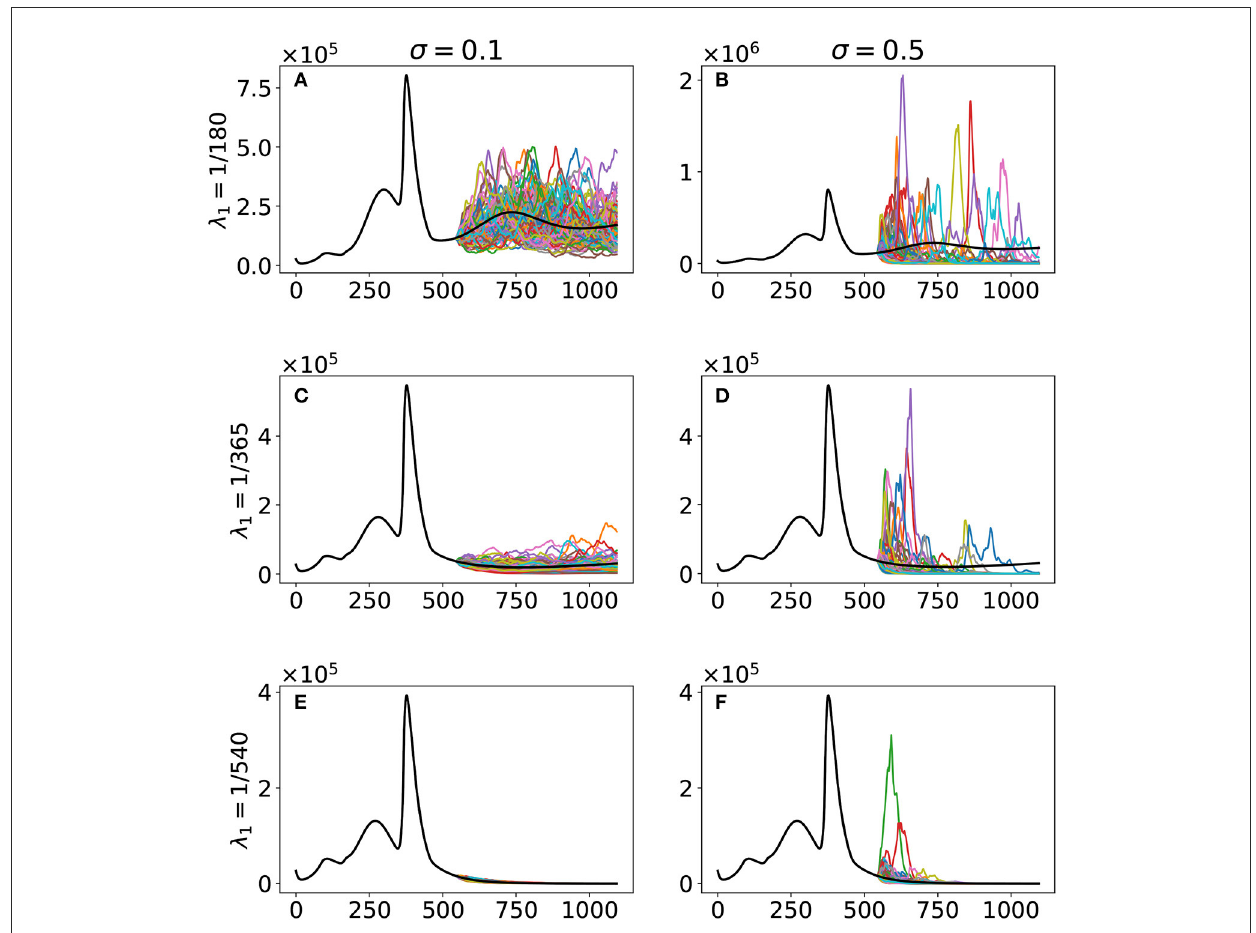
FIGURE5 Stochastic simulations with respect to the vaccine-induced immunity duration λ 1 and noise intensity σ . The curves are for the confirmed compartment. The black curve is the deterministic model output, while the colored curves are the realizations of the 100 runs of the stochastic model. The cases are as follows: (A) λ 1 = 1 / 180, σ = 0.1; (B) λ 1 = 1 / 180, σ = 0.5; (C) λ 1 = 1 / 365, σ = 0.1; (D) λ 1 = 1 / 365, σ = 0.5; (E) λ 1 = 1 / 540, σ = 0.1; (F) λ 1 = 1 / 540, σ =